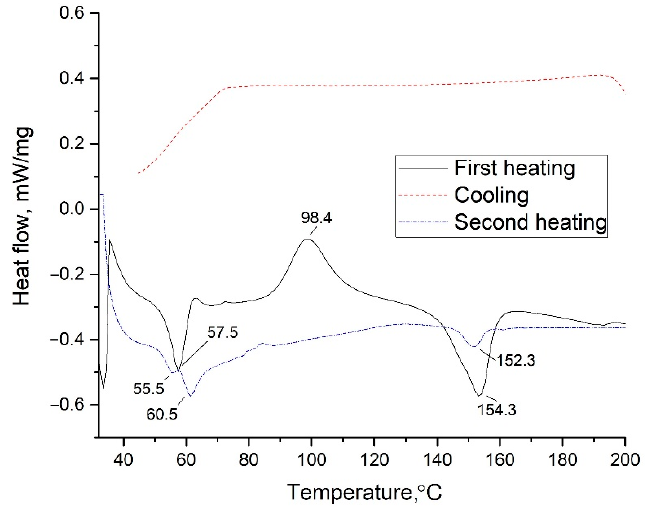
Figure 3. DSC curves for a polymer blend PLA + 10%PCL.